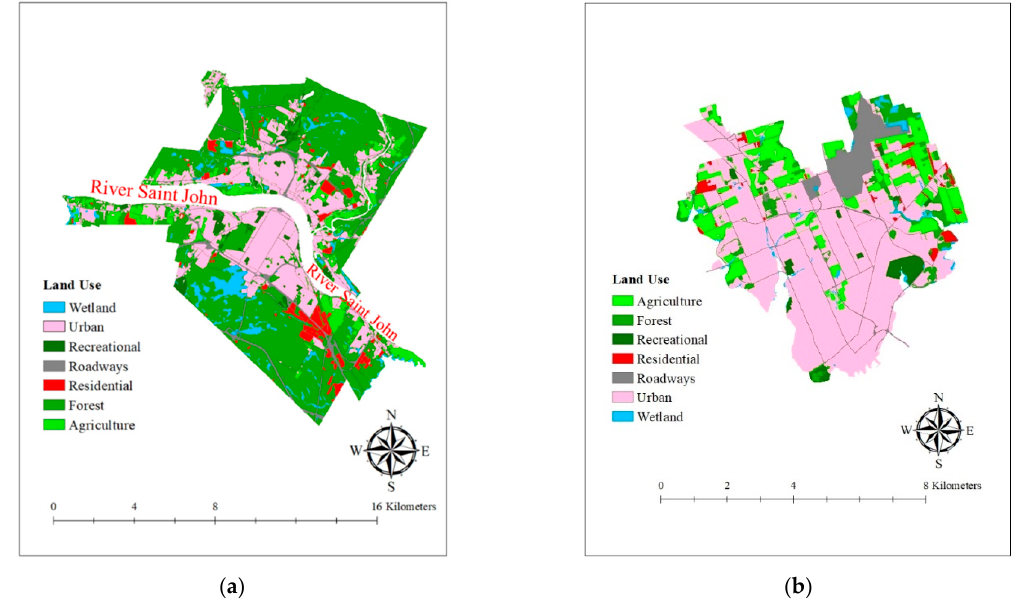
Figure 8. Land use components of Fredericton ( a ) and Charlottetown ( b ) reflecting urban designated areas prone to flood damage in watersheds of both cities.